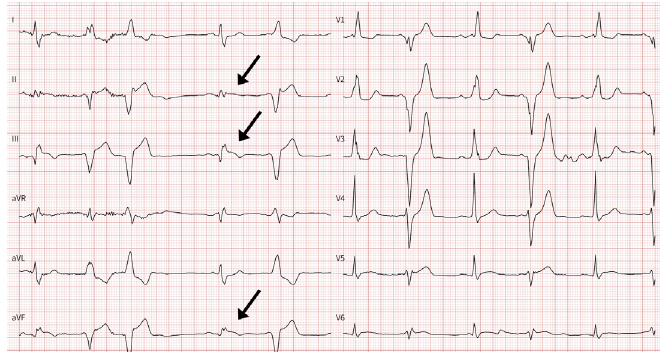
Image 2. 12-lead electrocardiogram at the presentation demonstrating the “spiked helmet” sign (black arrows) with reciprocal changes (white arrows).